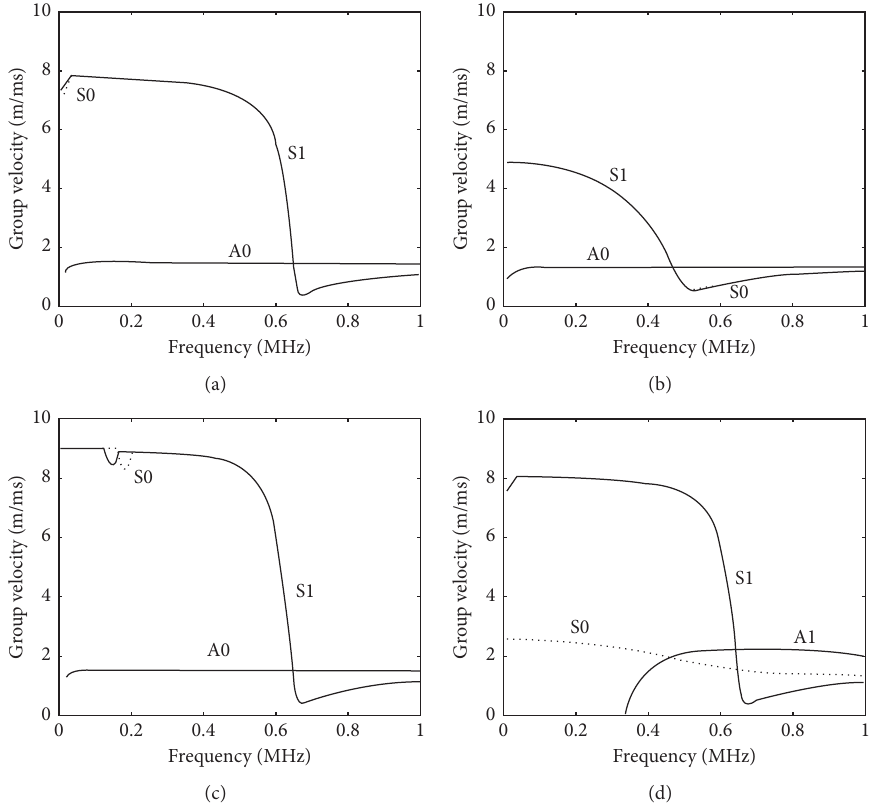
Figure 5: Dispersion curves of guided waves. (a) [0/90/0/90/0 100